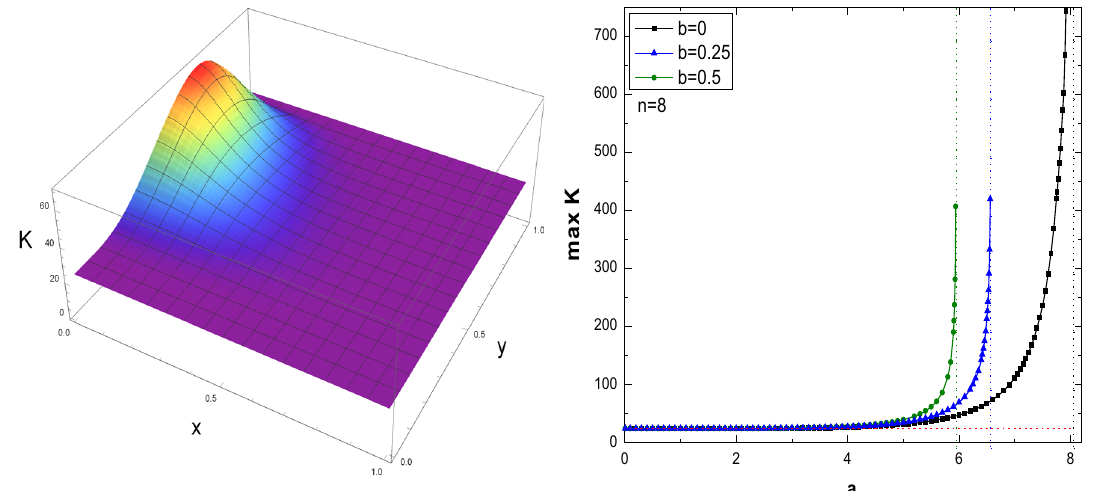
Fig. 1 Left: The distribution of Kretschmann scalar as a function of x and y coordinatewith b = 0 . 25, n = 8and a = 6.Right:Themaximum of the Kretschmann scalar as a function of a with the fixed Born–Infeld parameters b = 0 , 0 . 25 , 0 . 5, represented by the black, blue and cyan